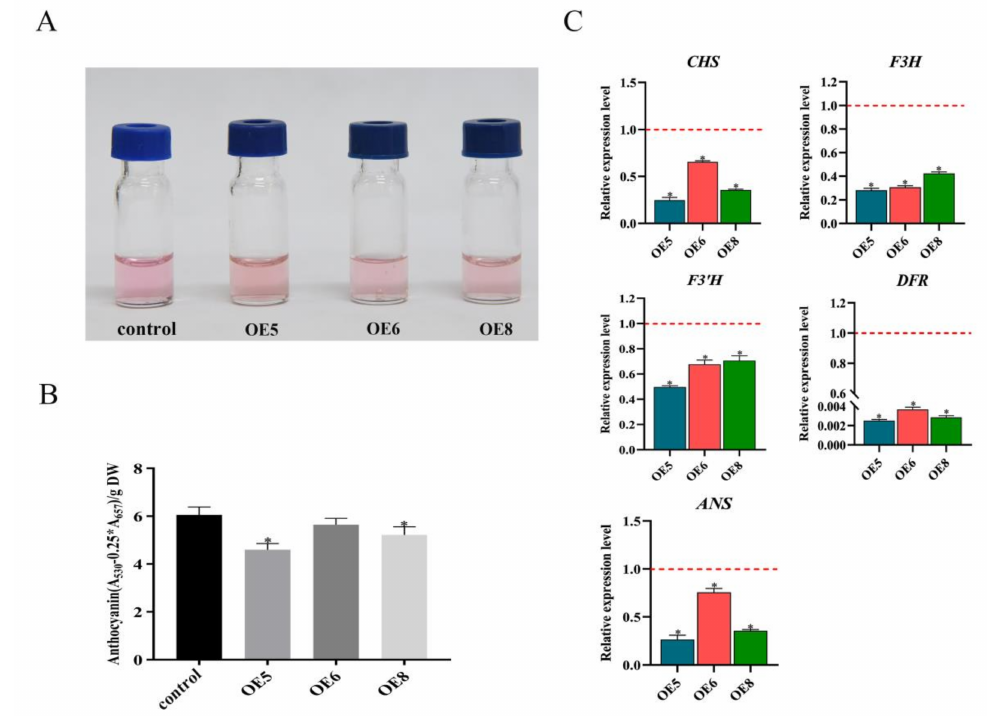
Figure 5. Sm SPL6 negatively regulates the biosynthesis of anthocyanin. ( A ) Anthocyanin extracted from the whole plant of the transgenic lines and the control. ( B ) Concentrations of anthocyanin in the transgenic lines and the control. ( C ) Expression changes of the enzyme genes for the biosyn- thetic pathway of anthocyanin. CHALCONE SYNTHASE ( CHS ), FLAVANONE 3-HYDROXYLASE ( F3H ), FLAVONOID 3 (cid:48) -HYDROXYLASE ( F3’H ), DIHYDROFLAVONOL REDUCTASE ( DFR ), AN- THOCYANIDIN SYNTHASE ( ANS ). All data are the means of three biological replicates, with error bars indicating SD. Red dotted lines indicate the control value, which was set to 1. * represents a significant difference at p < 0.05 compared with the